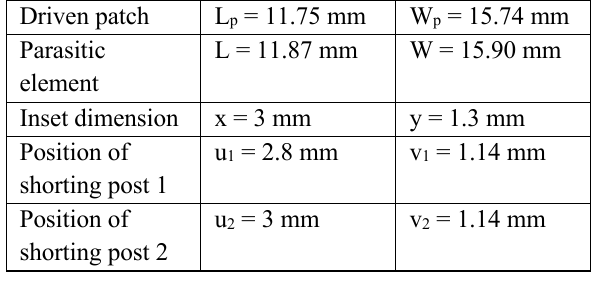
TABLE I. Optimal values of design parameters